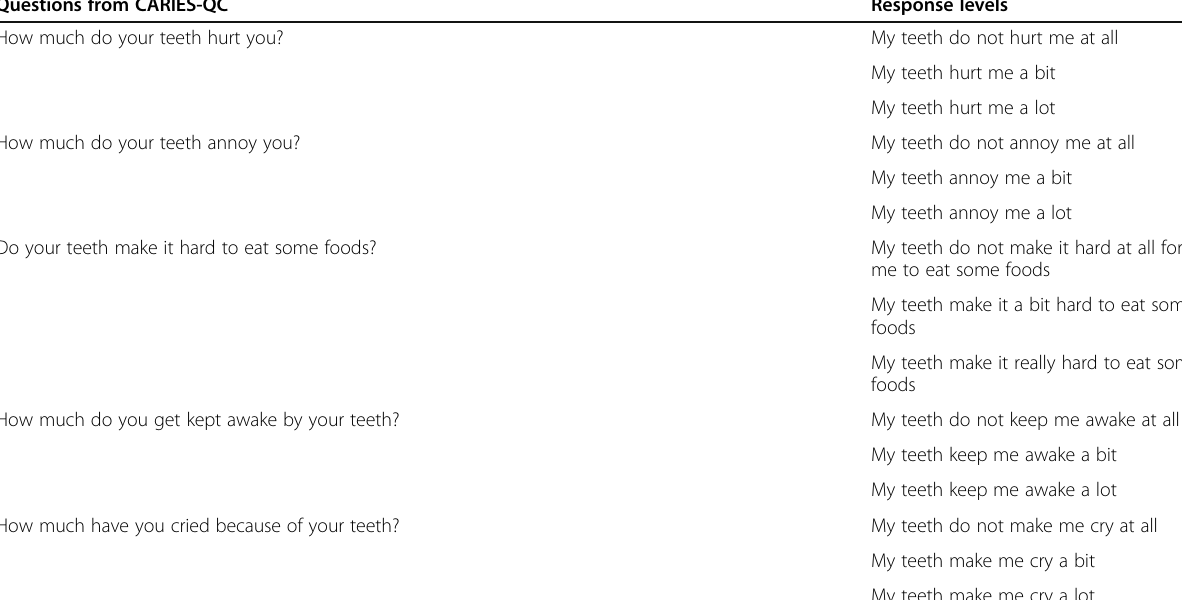
Table 1 The classification system for a caries-specific preference based measure and related questions from CARIES-QC Questions from CARIES-QC